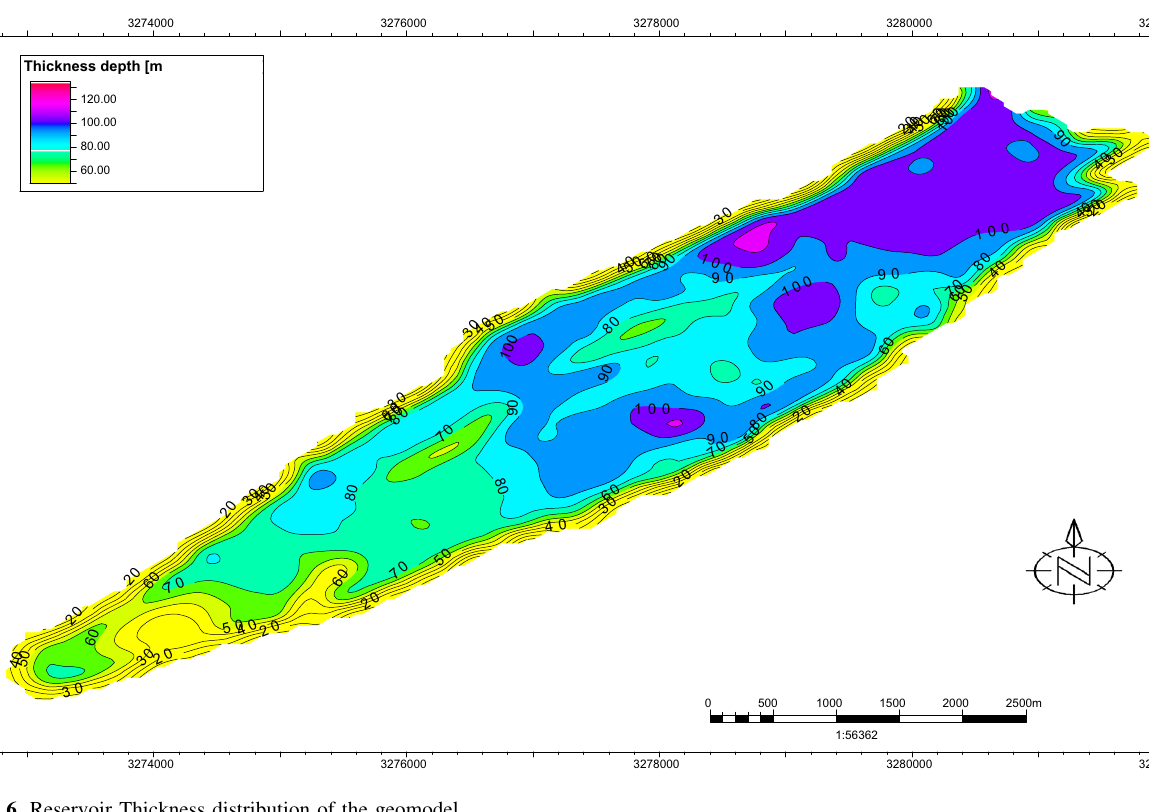
Fig. 6 Reservoir Thickness distribution of the geomodel